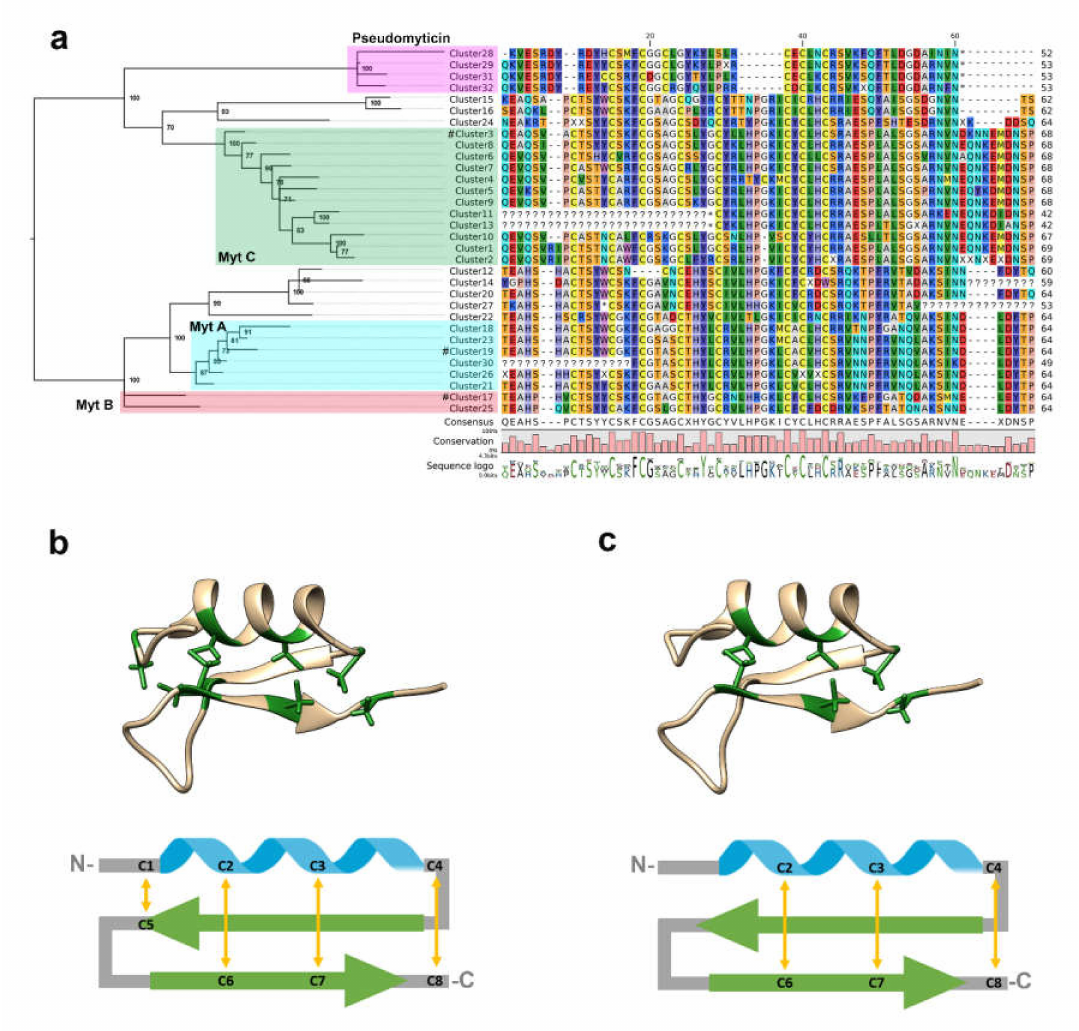
Figure 2. Clusters phylogenetic analysis and alignment. ( a ) A consensus sequence of each of the 32 myticin clusters (exon 3) was used to run the phylogenetic analysis and build the alignment. ? represents parts of sequences that likely resulted from an exon truncation event, thereby not finding any significant similarity with the classical myticin structure. X represents an ambiguous consensus sequence for a given codon in a given sequence cluster, resulting in an undetermined amino acid residue. * represents STOP codons. Green (MytC), red (MytB), blue (MytA), and purple (pseudomyticin) squares show the position of the four main described groups of myticins and pseudomyticins. # represents previously published Myt A / B / C sequences. ( b , c ) show the predicted secondary structure (green color highlights the cysteine positions) and the putative interaction of cysteines engaged in the formation of the disulfide bonds (yellow arrows) of conventional myticins and pseudomyticins,